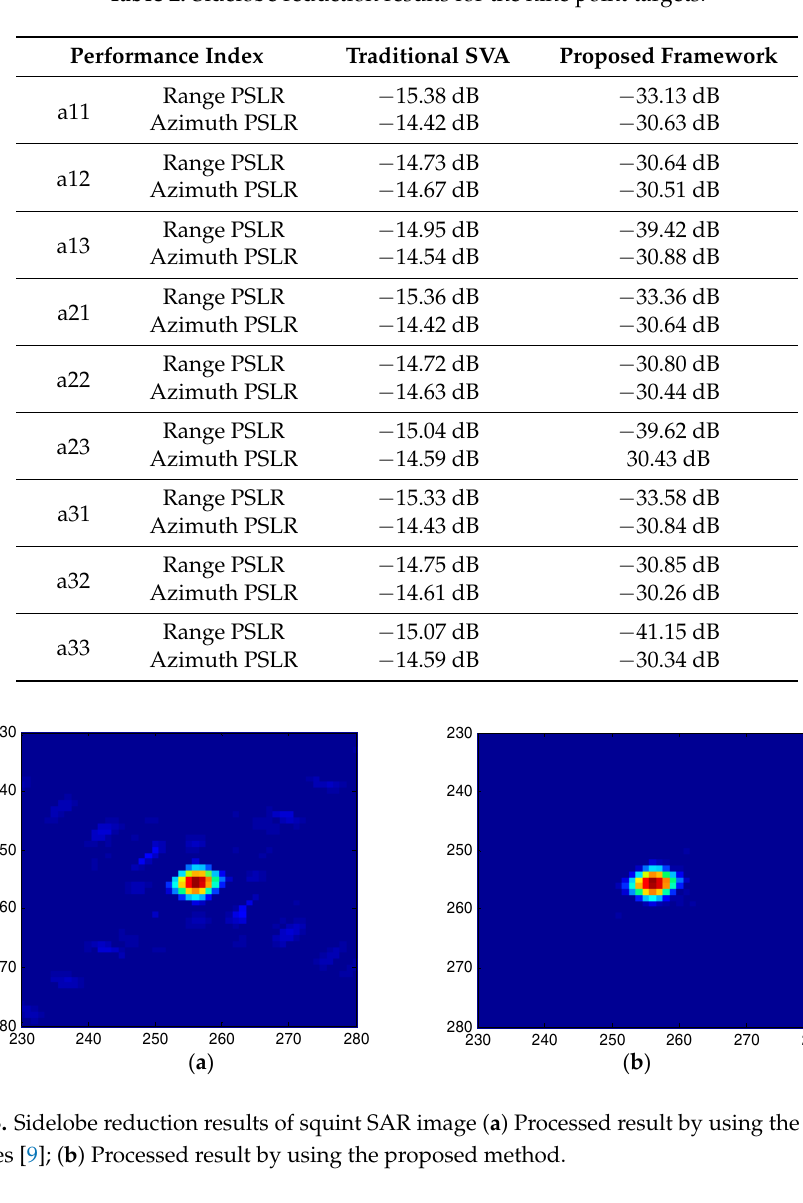
Table 2. Sidelobe reduction results for the nine point targets.